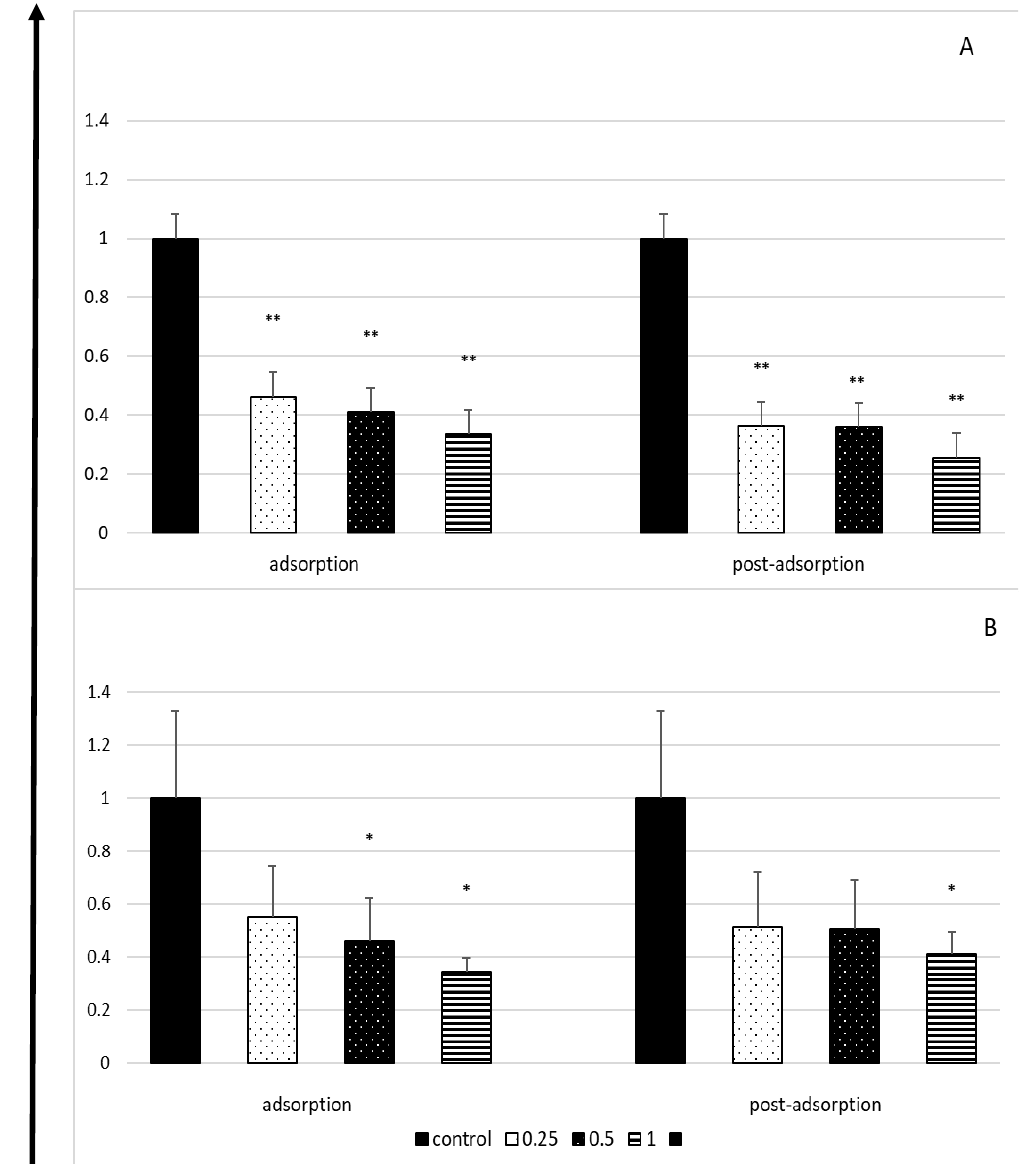
Figure 3. Effect of lactoferrin on viral RNA load in enterovirus E-infected cells after 6 h ( A ) and 18 h ( B ) of incubation (RT-qPCR). Lactoferrin (LF) concentrations in mg/mL; control: untreated cells. Lactoferrin present only during virus adsorption (adsorption) or added just after virus adsorption (post-adsorption). Amounts of intracellular enterovirus E RNA from control (lactoferrin-untreated) cells set as 1, results obtained from treated cells expressed as the relative amount of the control virus RNA. All data expressed as means ± SD (standard deviation) for three independent experiments ( n = 3). Asterisks refer to statistically significant differences between control and lactoferrin-treated cells at: * p < 0.05, ** p <